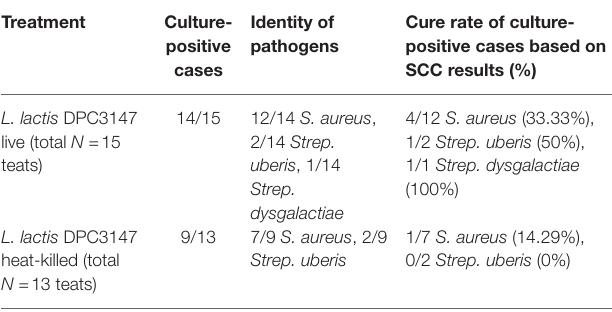
TABLE 1 | Total number of quarters infused with one of the two emulsion-based formulations, showing the etiological agents of mastitis.